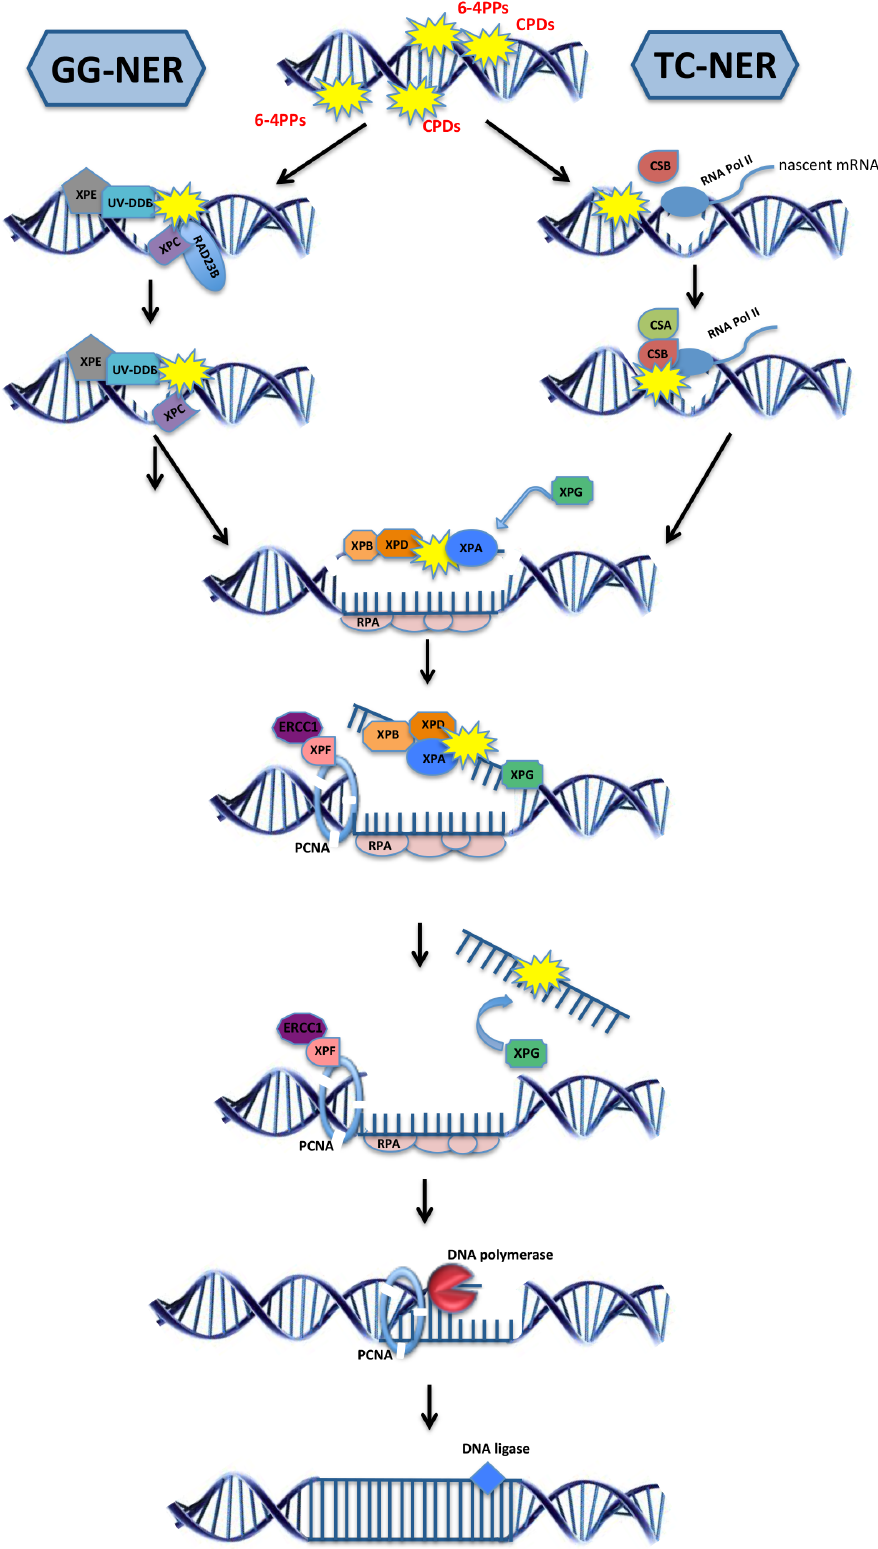
Figure 1. The two sub-pathways of the nucleotide excision repair. Global genome nucleotide excision repair (GG-NER; left) is initiated when the damage sensor proteins XPC and